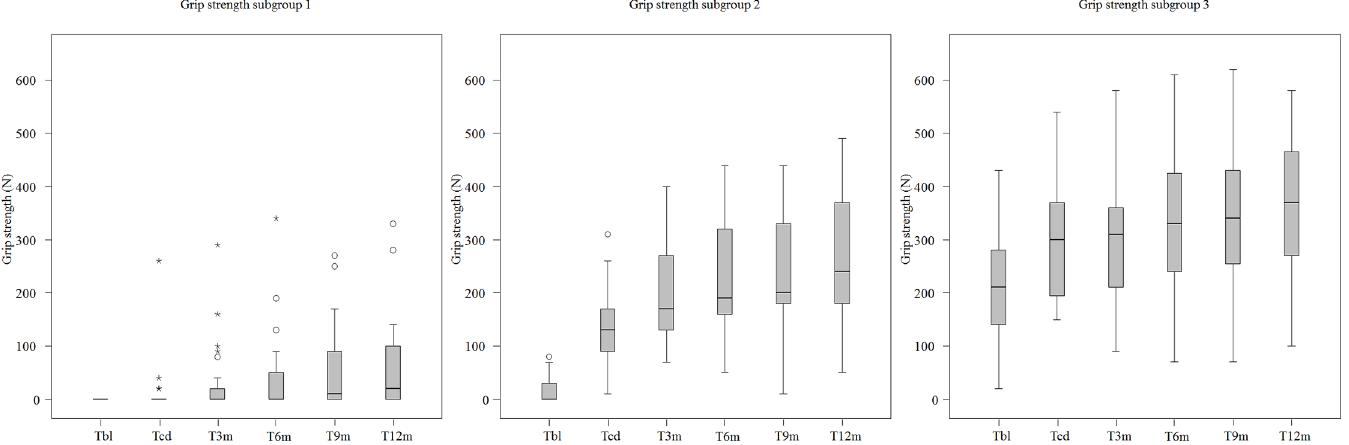
Fig 3. Boxplots of the grip strength data per measurement moment for each of the three groups. T BL = Baseline; T CD = ClinicalDischarge;T 3m = (= T CD + 3 months); T 6m (= T CD + 6 months); T 9m (= T CD + 9 months);T 12m (= T CD + 12 months). Circles = outlier value; Asterisk = far out